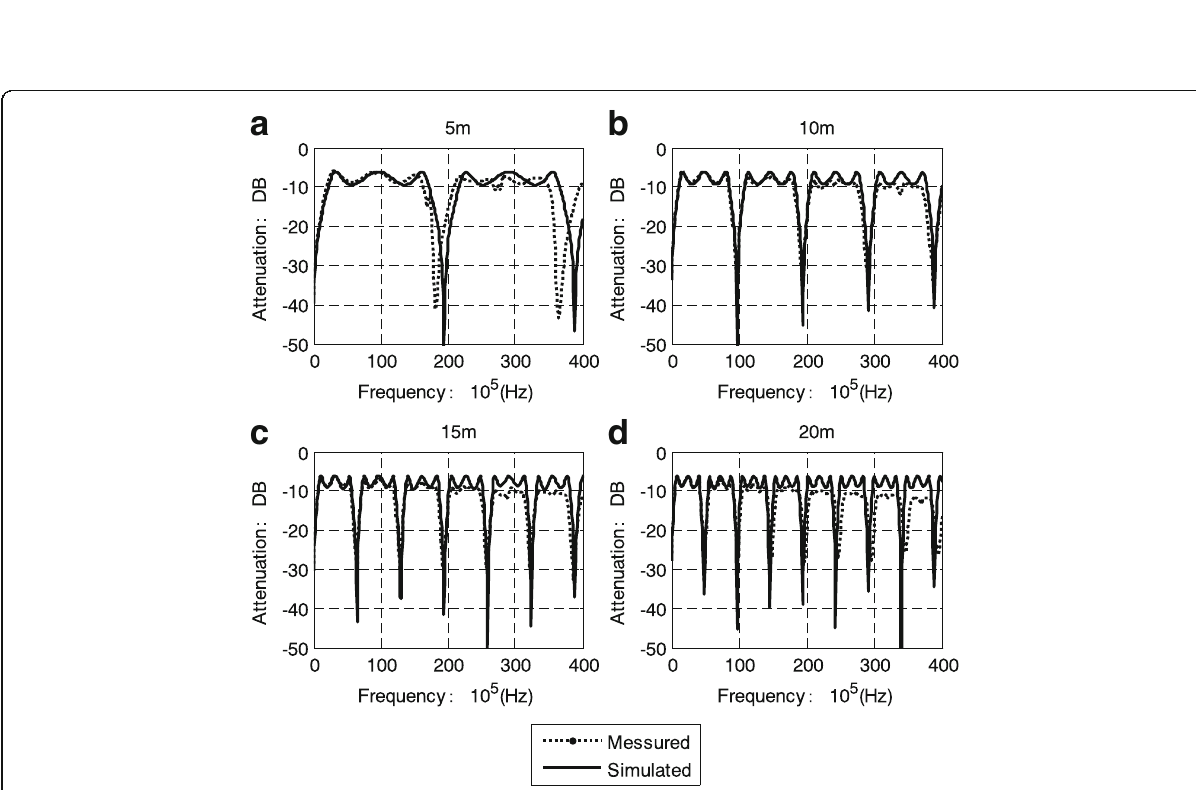
Fig. 20 Voltage transmission amplitude-frequency characteristic with proportional changes in the line length of the mesh topology ( a ) 5m ( b ) 10m ( c ) 15m ( d )